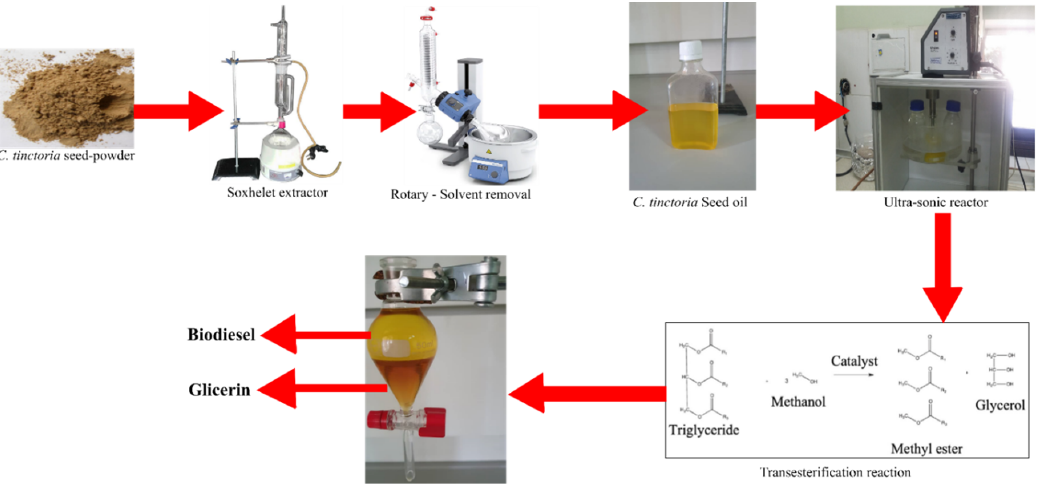
Figure 3. C. tinctoria biodiesel production process.